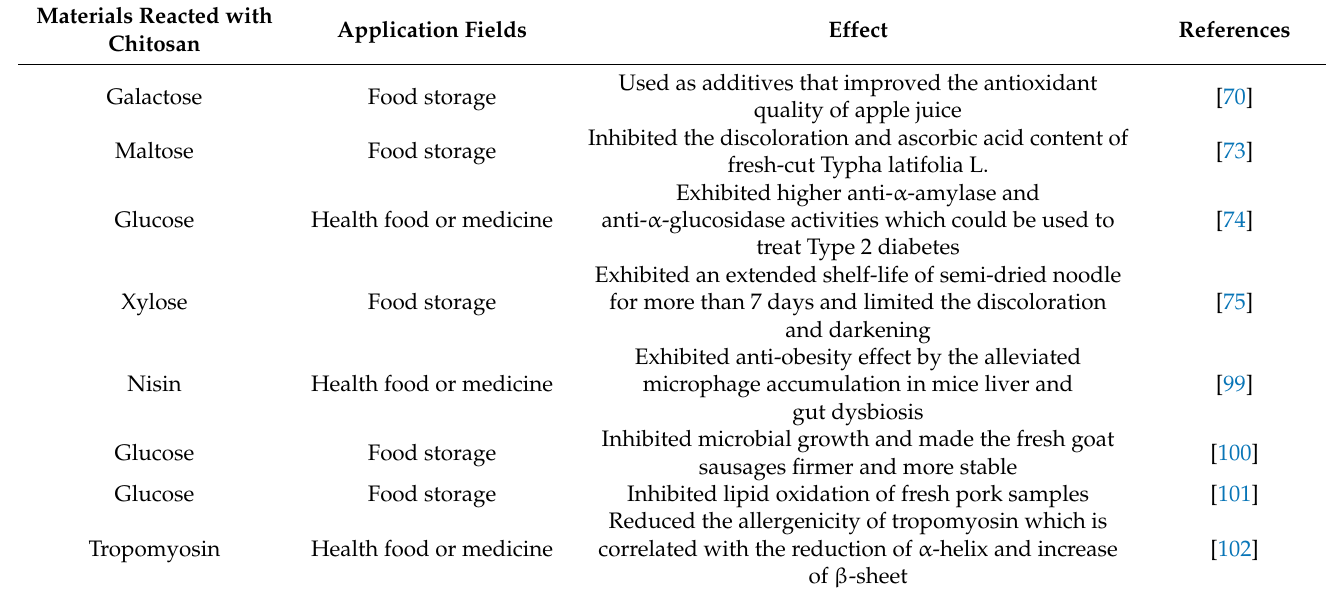
Table 2. An overview of CMRP